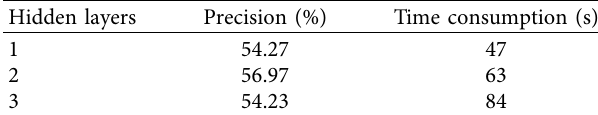
Table 4: Training precision and time of different hidden layers.